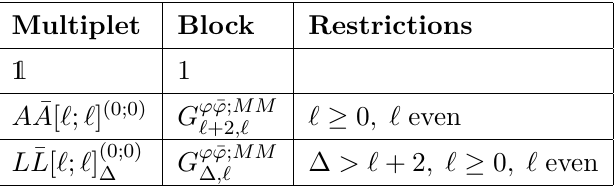
Table 5 . List of multiplets that appear both in the ϕ r × ¯ ϕ − r and M × M OPEs. For each multiplet, the superconformal block can be found in equation